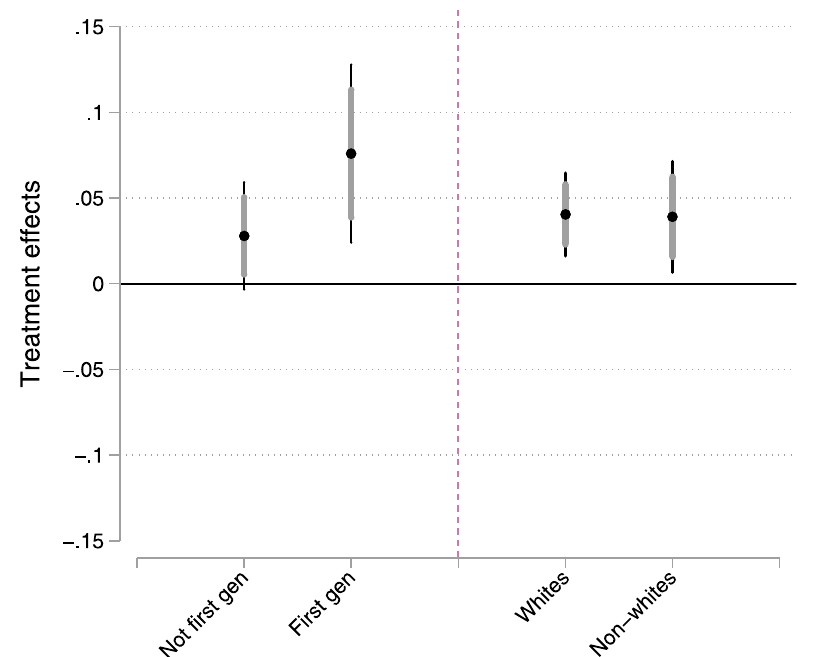
Fig 1. Treatment effects by first-generation status and race/ethnicity. Plot shows point estimates for difference of proportions tests comparing students in lottery email condition to those in encouragement email condition. Thin vertical lines are 95% confidence intervals while thick vertical lines are 84% confidence intervals. If 84% confidence intervals do not overlap, we can be 95% confident that the two estimates are different.